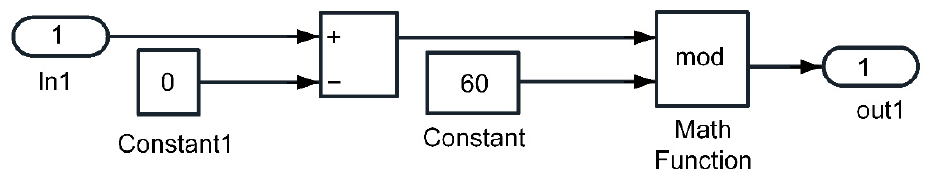
Figure 7. Rotor position conversion module.